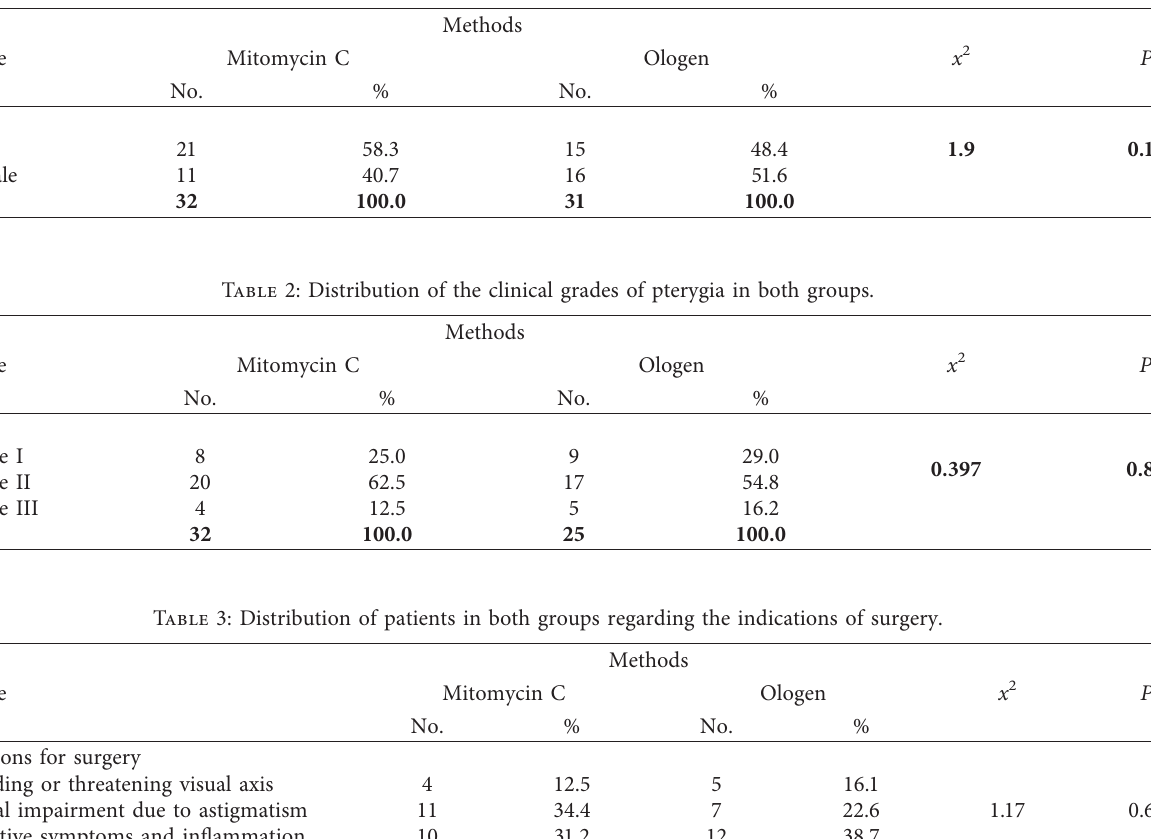
Table 1: Distribution of patients in both groups according to their gender.